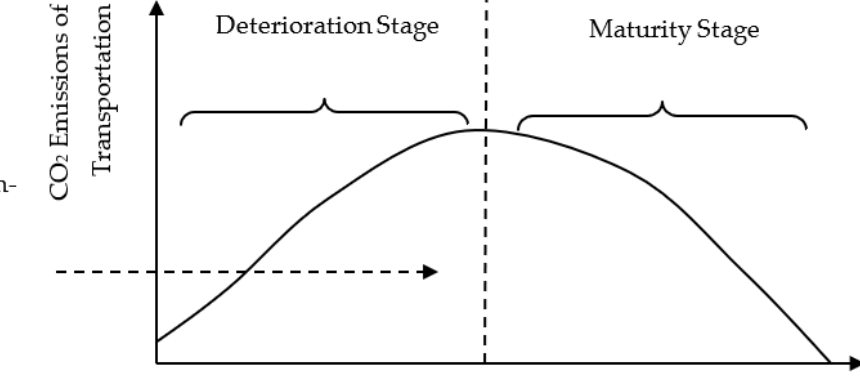
Figure 1. Theoretical Framework (Inverted U-Shaped EKC).